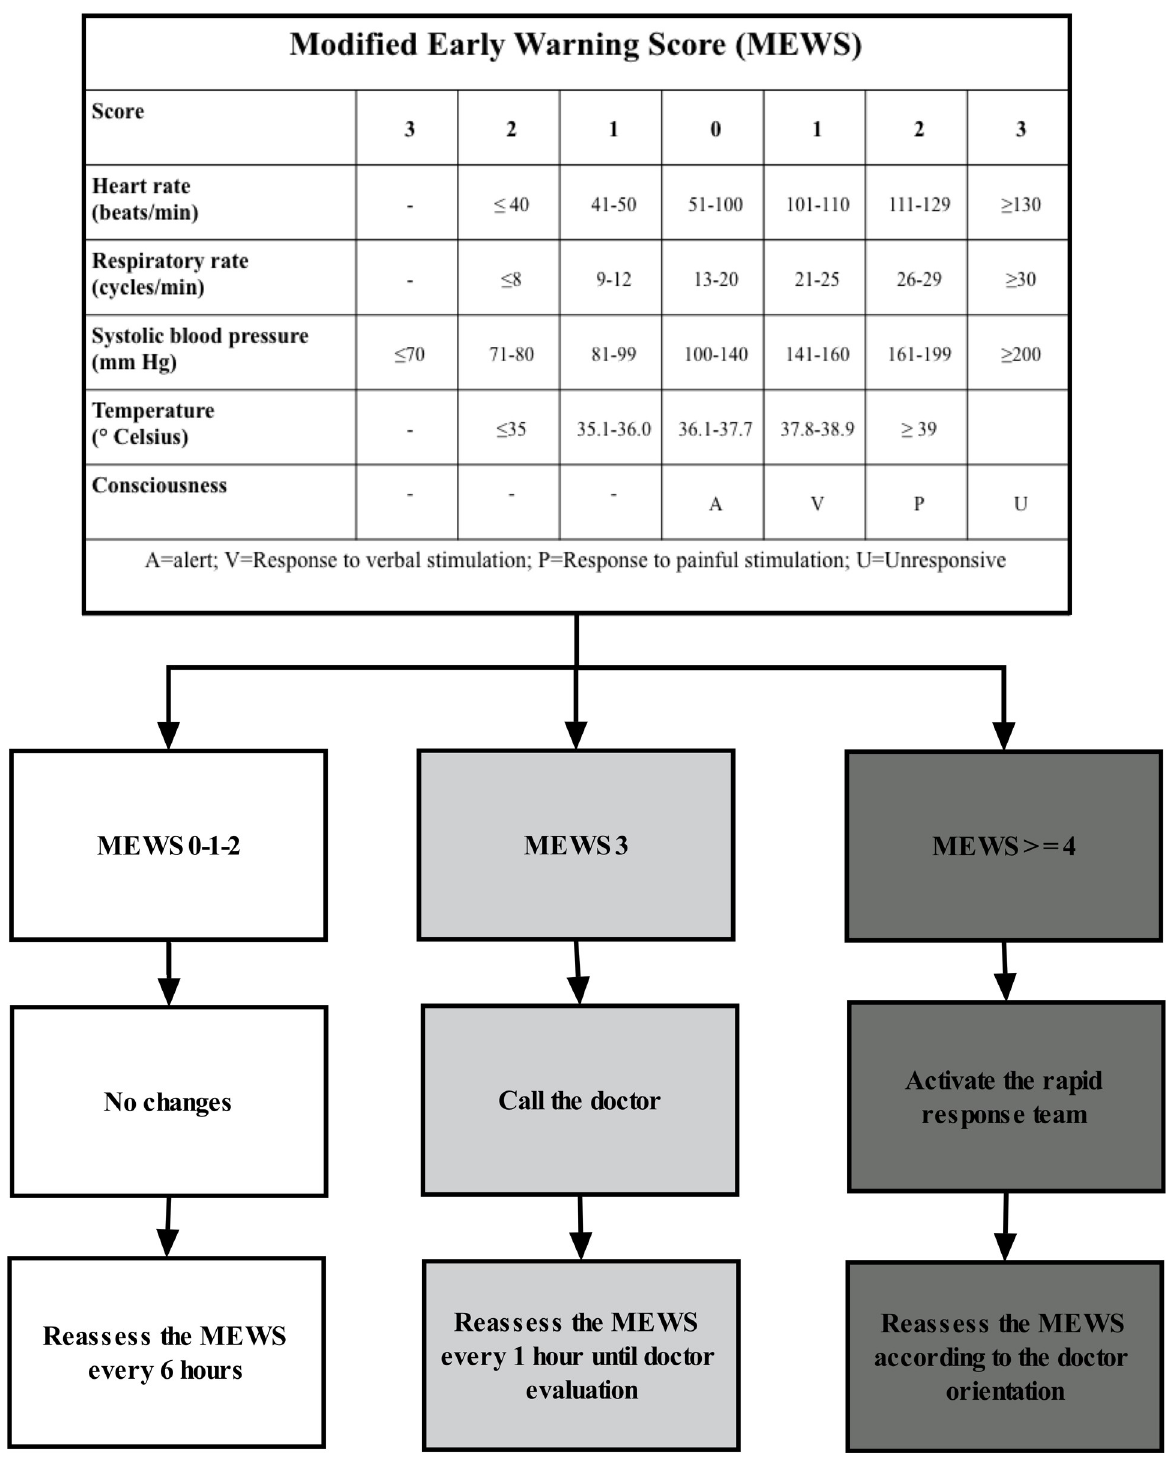
Fig 1. Type of response triggered by each Modified Early Warning Score (MEWS) value in the rapid-response team (RRT) implemented in the wards that offer emergency department support in this research.